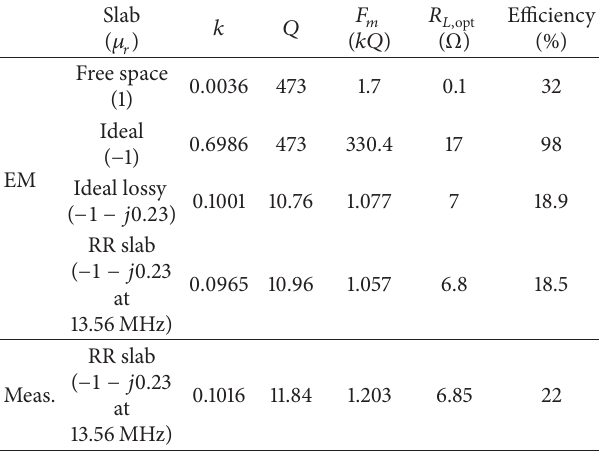
Table 2: Coupling coefficients, 𝑄 -factor, and WPT efficiencies for the free space case and for the cases of using lossless and lossy